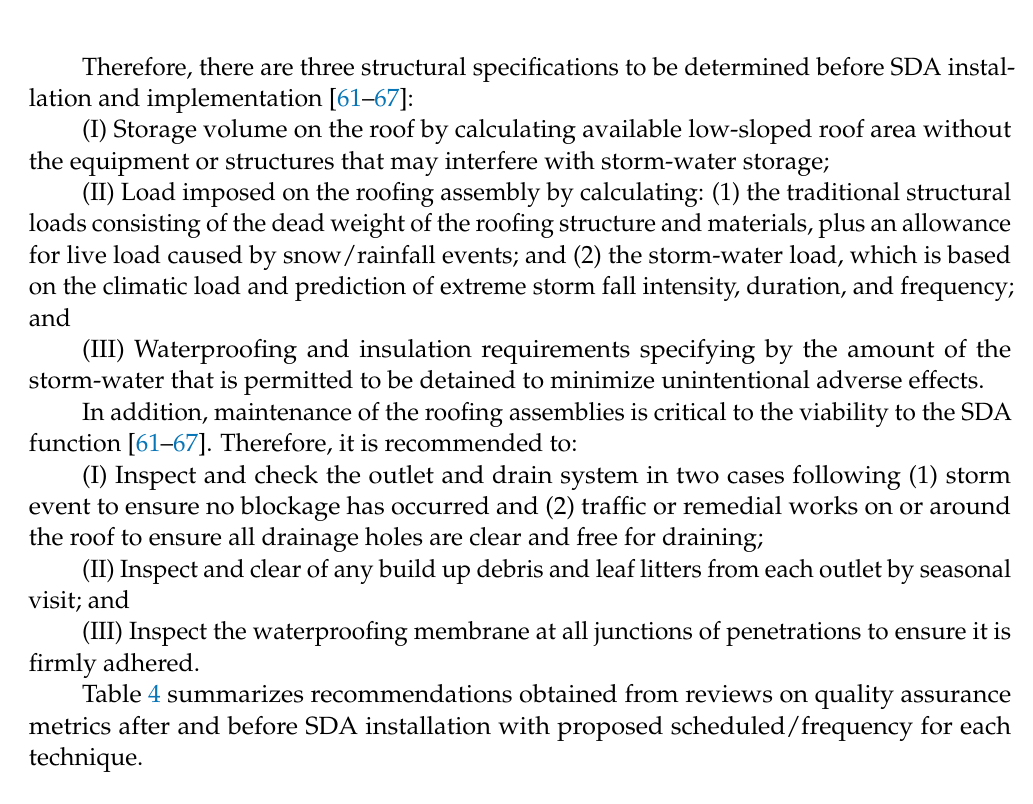
Table 4. Recommendations on quality assurance metrics before and after SDA